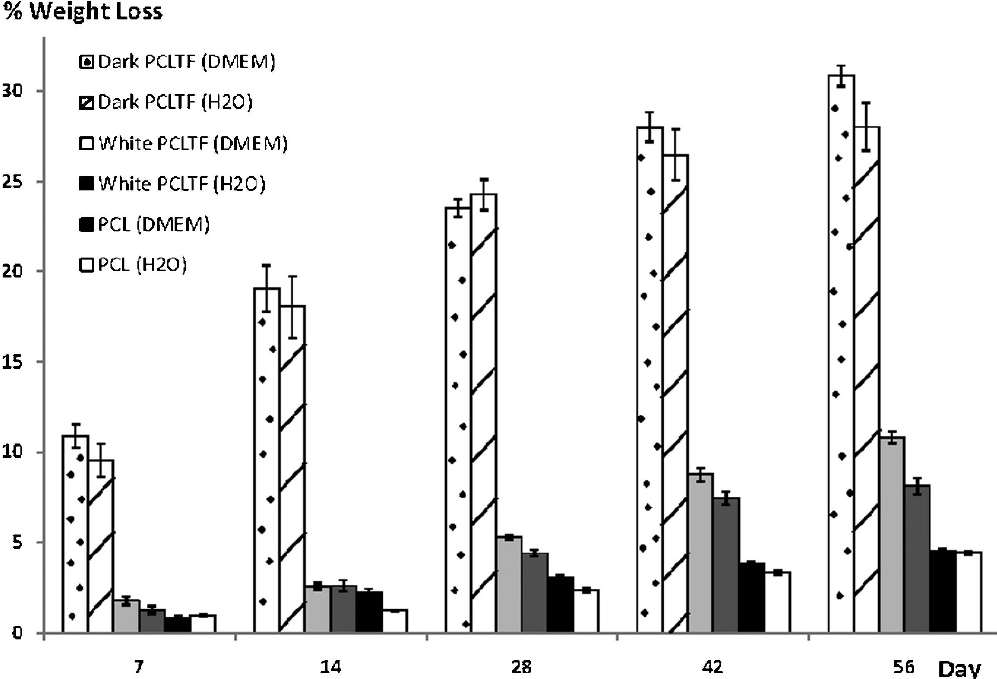
Figure 3 - Percentage weight loss over time of dark PCLTF, white PCLTF, and PCL scaffolds immersed in DMEM or distilled water, with 95% confidence intervals. Weight loss was measured in five independently incubated samples. Dark PCLTF demonstrated the highest degradation, followed by white PCLTF and PCL (30.86 ¡ 1.15%, 10.83 ¡ 0.66%, and 4.55 ¡ 0.26%, respectively, by day 56, immersed